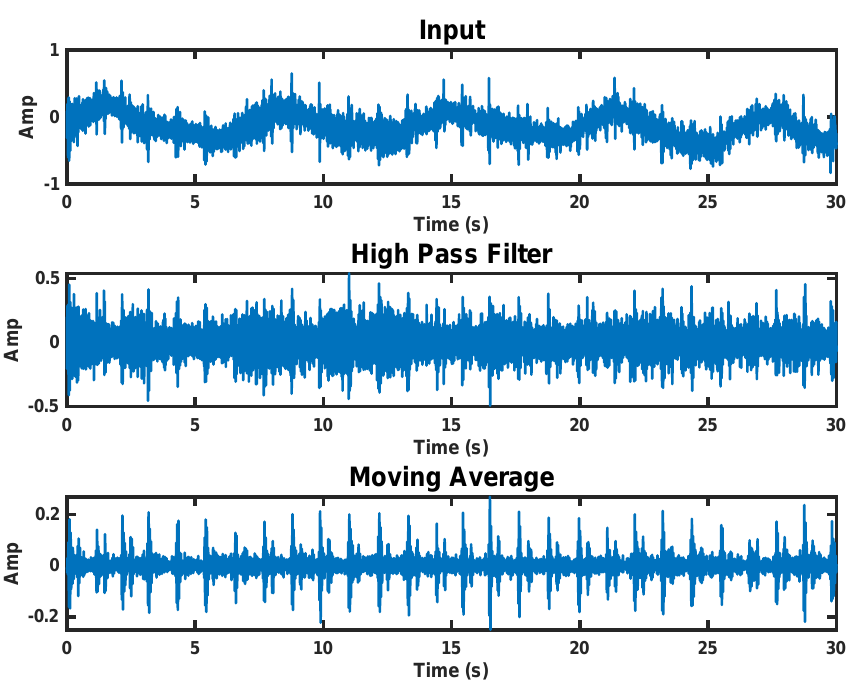
Figure 7. Accelerometer signal processing steps. The top plot shows the raw signal. The middle plot has a high − pass filter applied. The bottom plot is the final processed signal with a moving average